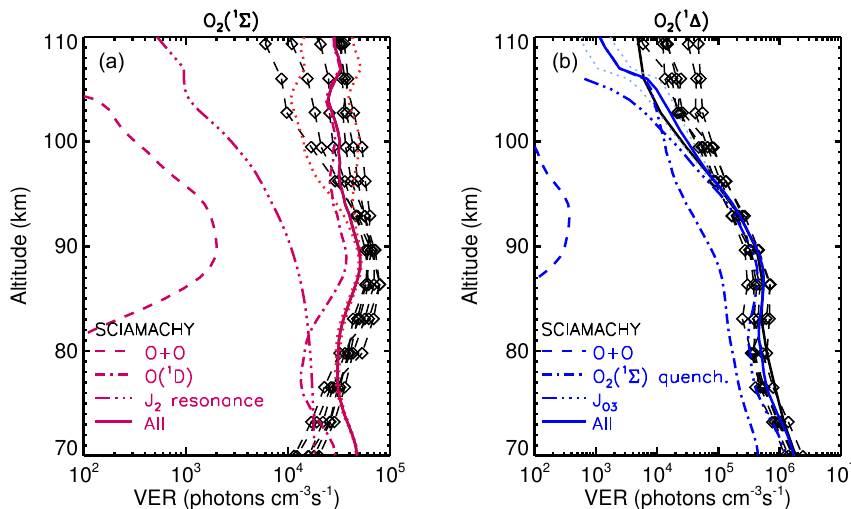
Figure 9. Modeled VERs of O 2 ( 1 (cid:54)) (a) and O 2 ( 1 (cid:49)) (b) . Solid lines are the mean of all model results for solar zenith angles 0, 10, 20, 30, 40, 50, 60, 70, 80, and 88 ◦ considering all formation processes; dotted lines show the variability due to photolysis reactions ( ± standard devi- ation). The dashed, dash-dotted, and dash–dot–dot lines show the contributions of individual formation processes: O + O, O ( 1 D ) quenching, and resonant excitation for O 2 ( 1 (cid:54)) , O + O, O 2 ( 1 (cid:54)) , and ozone photolysis for O 2 ( 1 (cid:49)) . Black lines with symbols are SCIAMACHY profiles at five latitudes observed on 3 February 2010 (see Fig. 5).